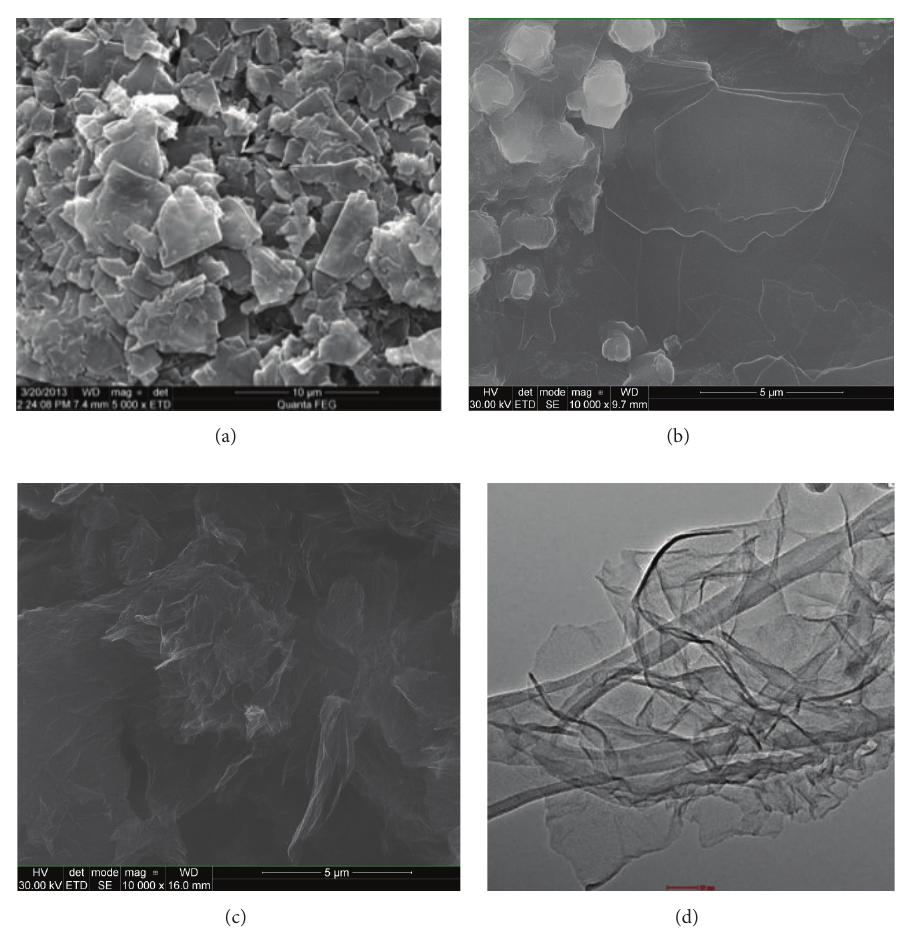
Figure 1: Microphotographs of graphite (a), graphene oxide (b), reduced graphene oxide (c) SEM, and reduced graphene oxide (d) TEM.